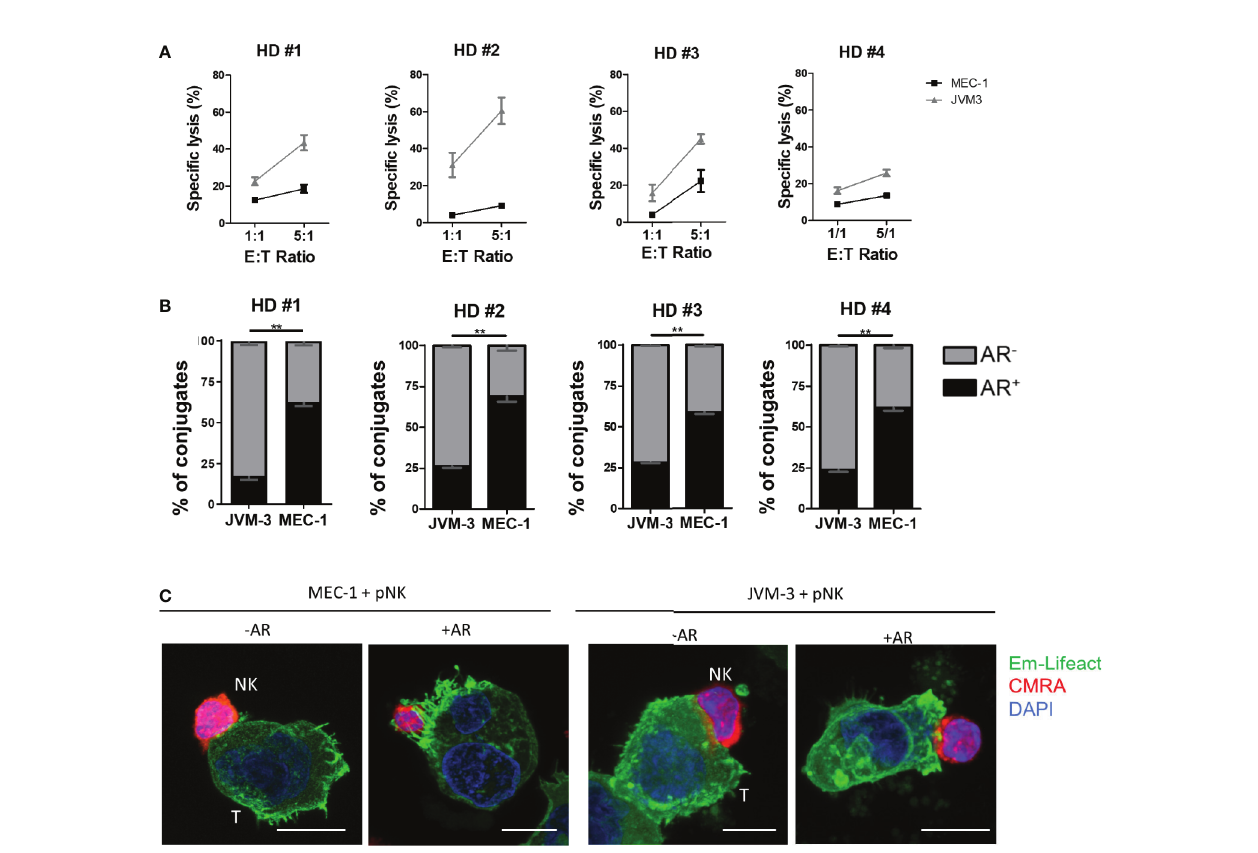
FIGURE 4 | Primary human NK cells can invoke the actin response in MEC-1 and JVM-3 cells. (A) Cytotoxicity assay with primary NK cells isolated from four healthy human donors and JVM-3 and MEC-1 CLL target cells at 1:1 and 5:1 E:T ratios. Target cells and primary NK cells were co-cultured for 4 hrs before analysis of NK cell-speci fi c lysis by fl ow cytometry. (B) Quantitative analysis of primary NK-CLL conjugates with (black, AR + ) and without (grey, AR - ) actin response by imaging fl ow cytometry. For each donors a minimum of 200 conjugates were analyzed. ** denotes p < 0.001 (C) Representative confocal microscopy pictures of primary NK cells (CMRA, red) in conjugation with MEC-1 (left) and JVM-3 (right) cells with or without an actin response. Bars: 10